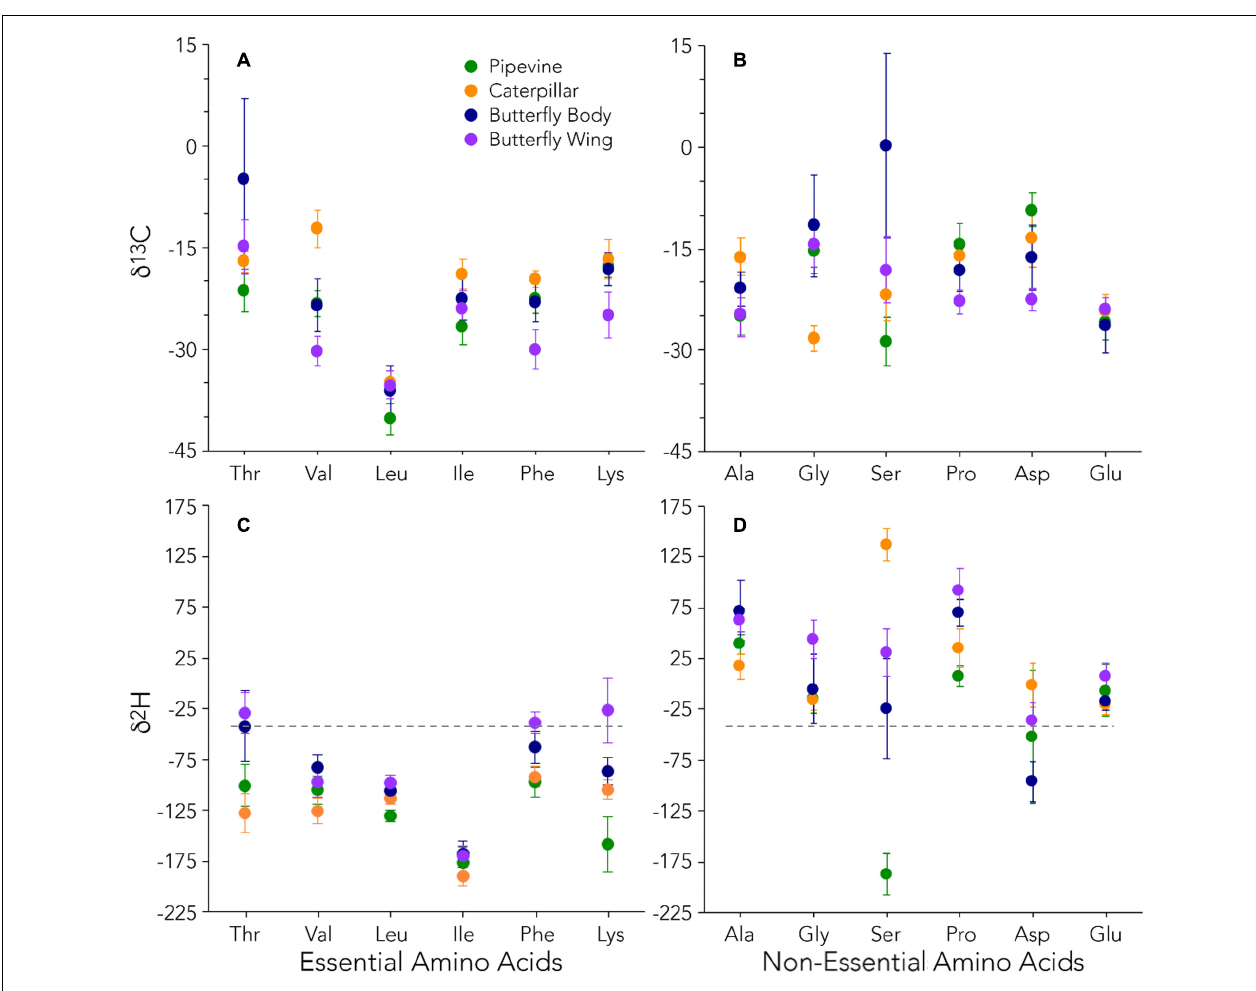
) for local water at the time of sample (cid:104)